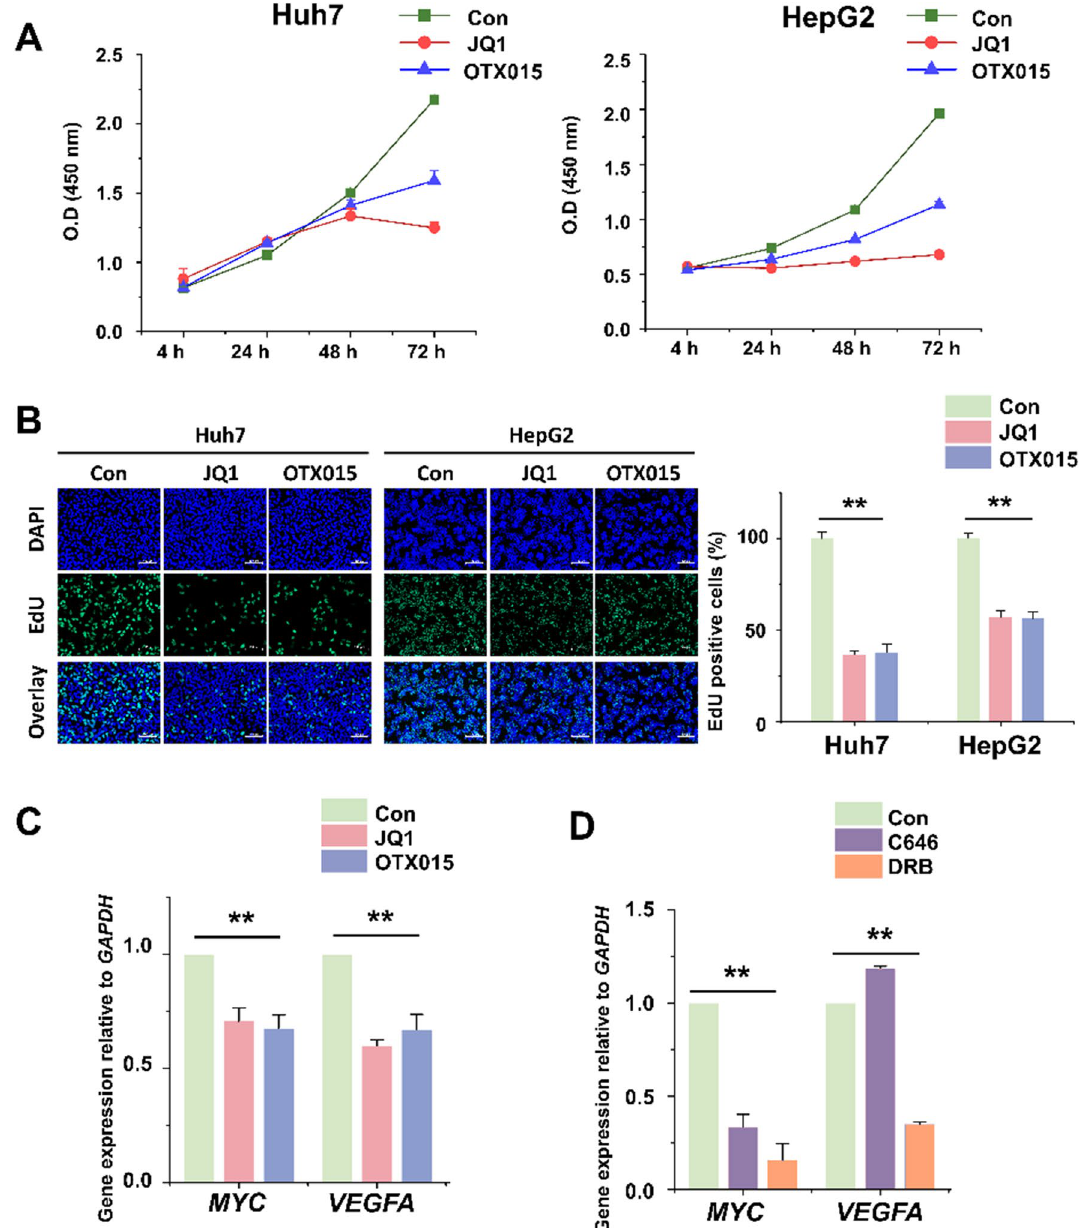
Figure 1. BET inhibitor suppresses cell viability, cell proliferation, MYC expression, and MYC target gene expression in Huh7 and HepG2 cells. ( A ) Cell viability was determined by the WST1 assay and represented by the relative absorbance at 450 nm. Huh7 and HepG2 cells were treated with 5 µM BET inhibitors (JQ1 or OTX015) for different durations (4 h, 24 h, 48 h, and 72 h). ( B ) The proliferation of Huh7 and HepG2 cells treated with 5 µM BET inhibitors for 24 h was assessed by EdU assay. Representative images and the number of EdU-positive cells (%) are shown. Original magnification, × 400. The data represent three biologically independent experiments. ** p < 0.01. ( C ) qRT-PCR analysis of MYC mRNA and MYC target genes and VEGFA mRNA in BET inhibitor-treated HepG2 cells (5 µM, 24 h). ( D ) qRT-PCR analysis of MYC mRNA and MYC target genes, VEGFA mRNA in p300/CBP inhibitor, C646 or RNA polymerase II (RNAPII) transcription elongation inhibitor, DRB-treated HepG2 cells (50 µM, 6 h). The values are presented as the mean ± SD from triplicate well measurements. * p < 0.05 and ** p <